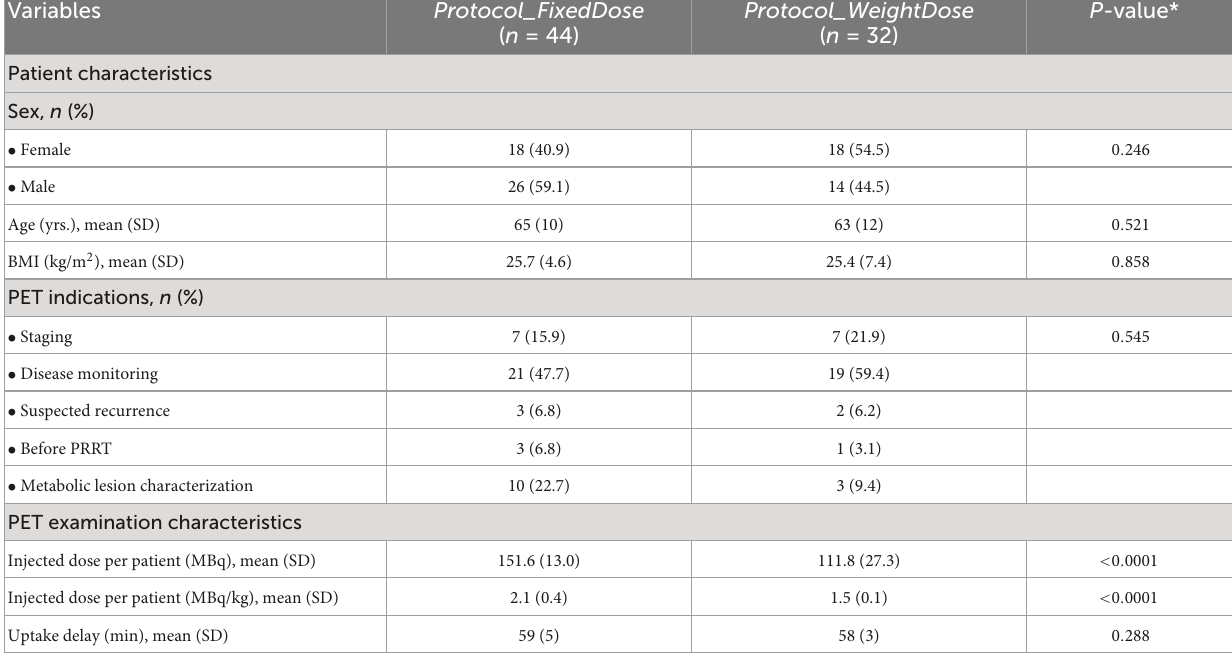
TABLE 1 Patients and PET examination